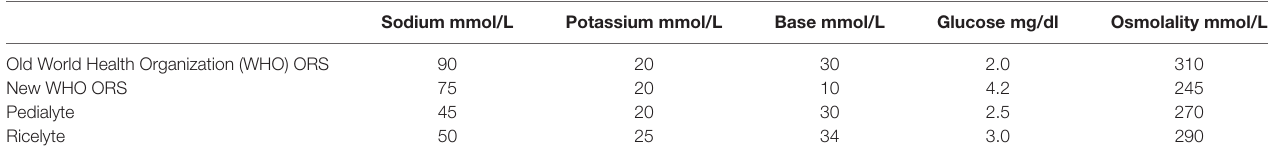
TABLe 12 | Compositions of some common oral rehydration solution-ORS (16, 55,